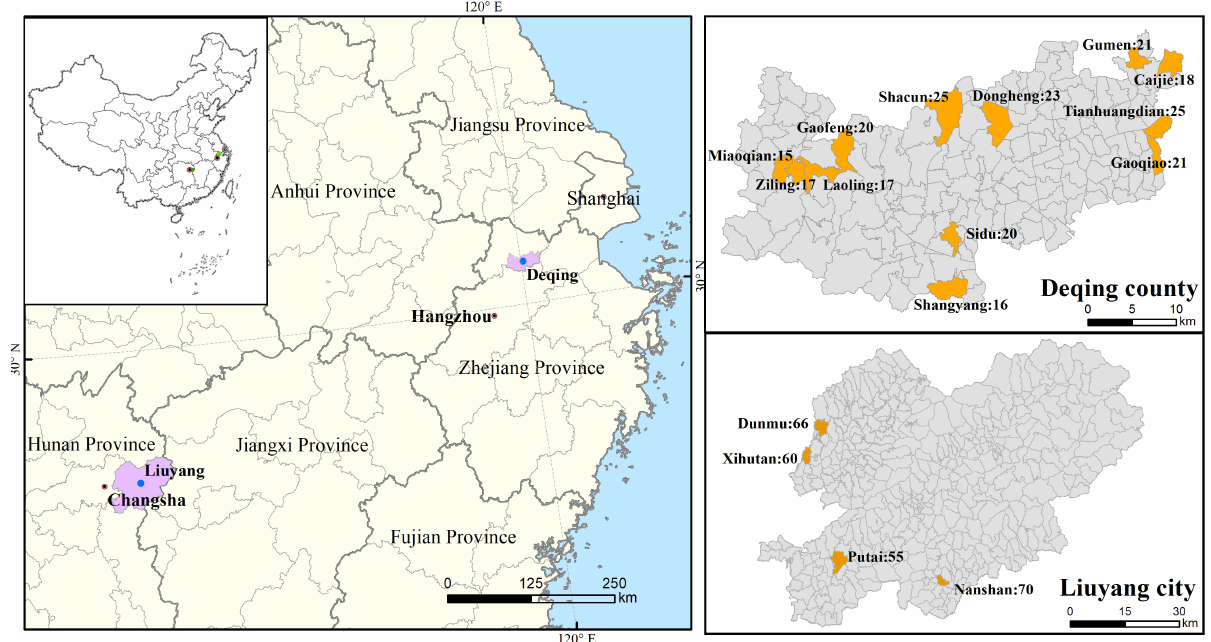
Figure 2. Location of the study